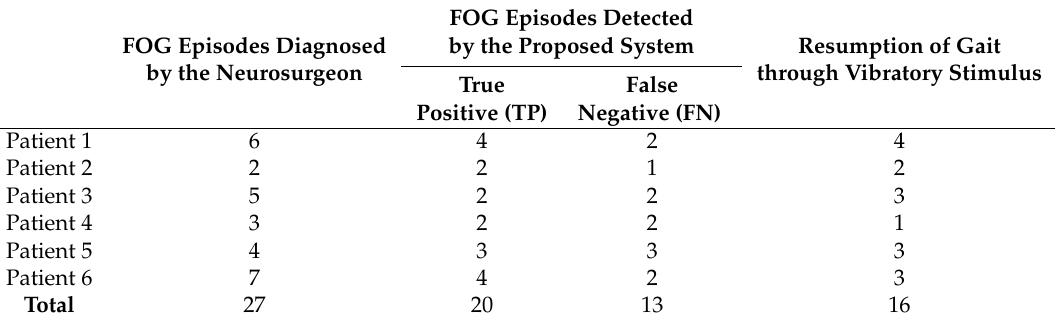
Table 3. Results and resumption of gait for patients with episodes of